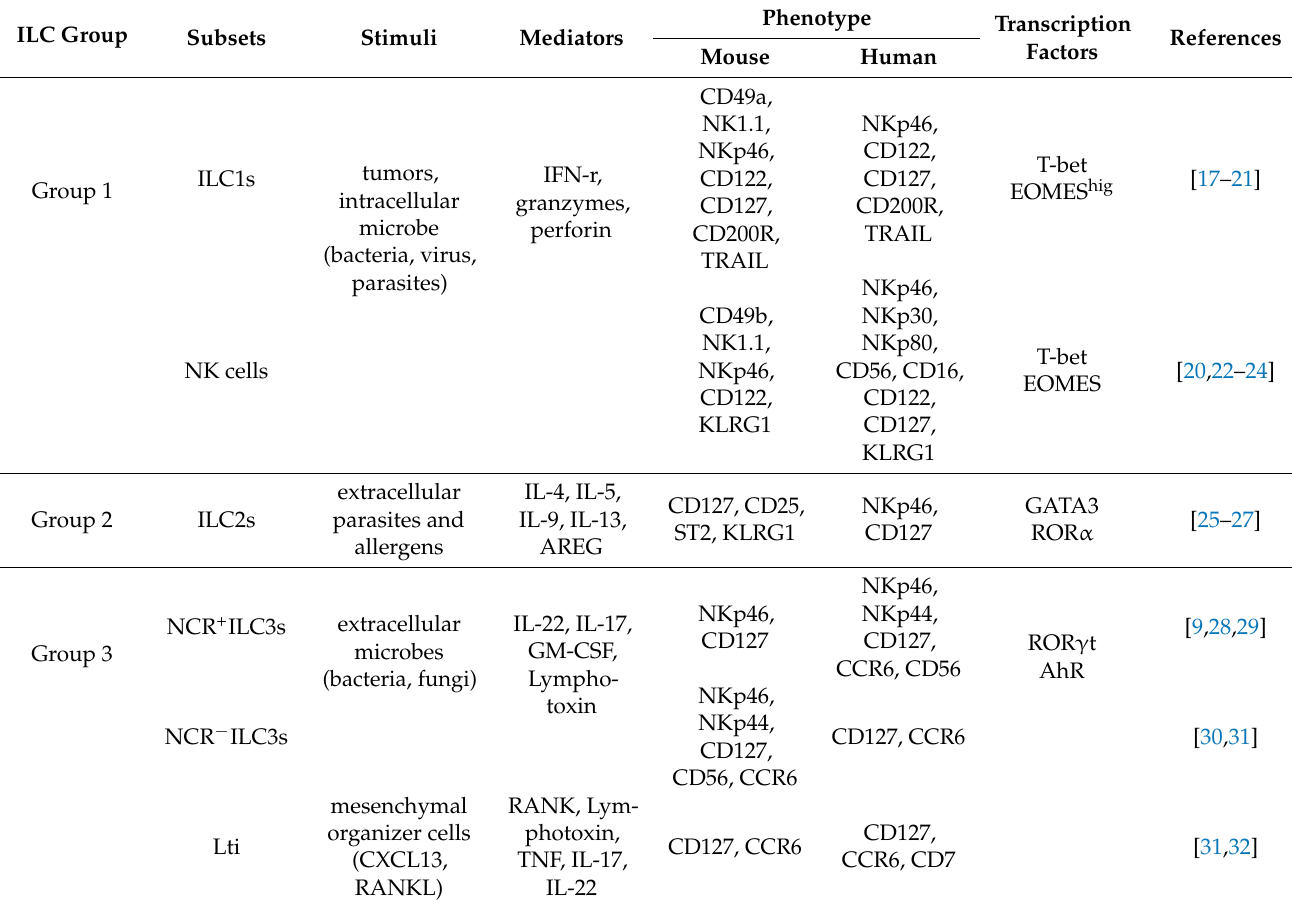
Table 1. Characteristics of innate lymphoid cells in mouse and